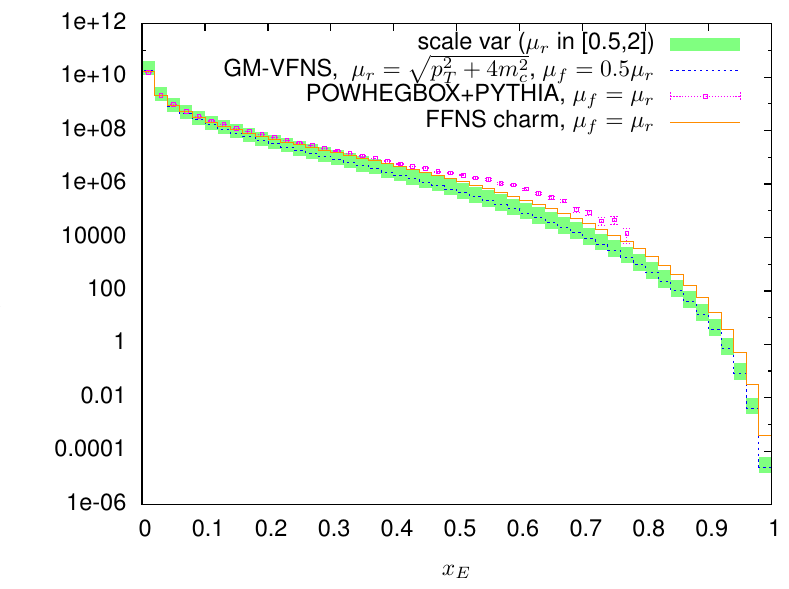
0 hadroproduction for colliding protons with E for D 433 GeV). (cid:25)